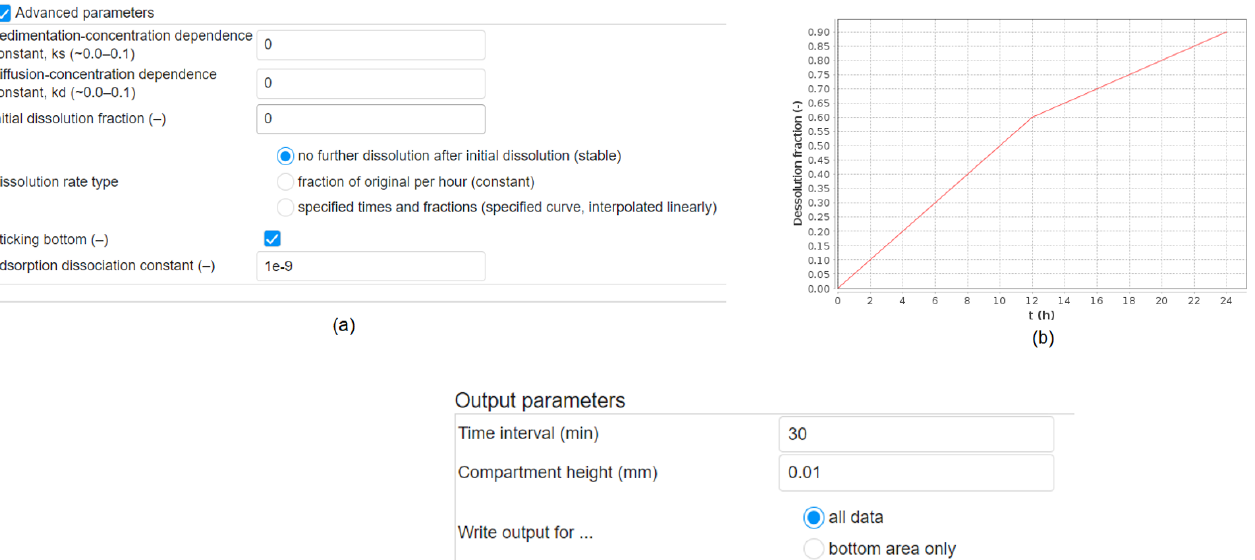
Figure 3. The Solvent parameters needed as input, shown in this case for ultrapure water, and the Simulation parameters section, which are used to describe the vessel in which the NPs are dispersed or the cell culture dish in which the NPs are administered. The Advanced parameters section. ( a ) The basic input which gives information on the rates of sedimentation and diffusion (default values are set to zero) and describes the dissolution status of the NPs ’ dispersion and the rate of dissolution (if any), and whether an attachment factor is required, for example, due to the presence of an adherent layer of cells at the bottom of the well. ( b ) Example of Dissolution fraction versus time, t (in hours), if the user selects to specify times and fractions in Dissolution rate type. The Output parameters section, where the user selects the time period for the simulation, the height of the exposure vessel (e.g., the cell culture dish) and whether they want to record the NPs ’ concentrations throughout the vessel or only for the bottom layer.